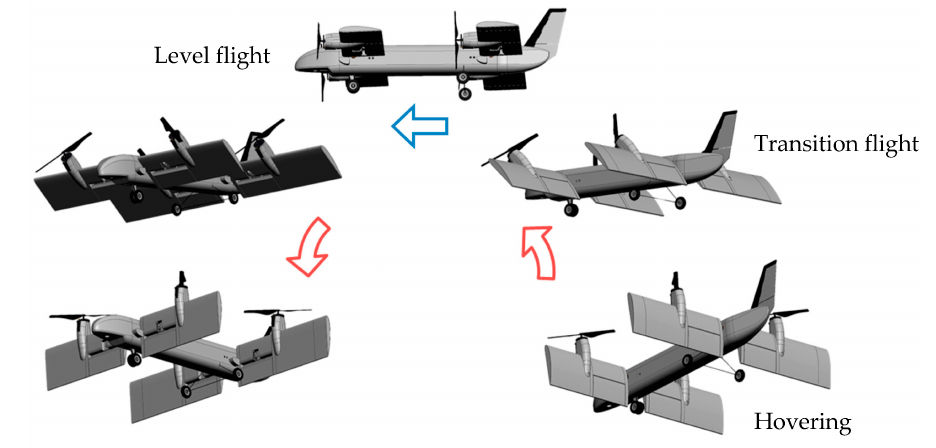
Figure 1. Flight configuration.